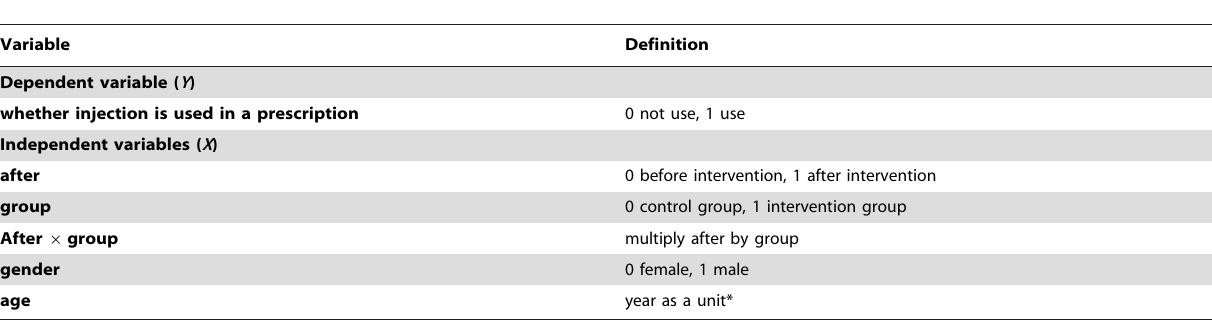
Table 2. Definition of independent variables and dependent variable.